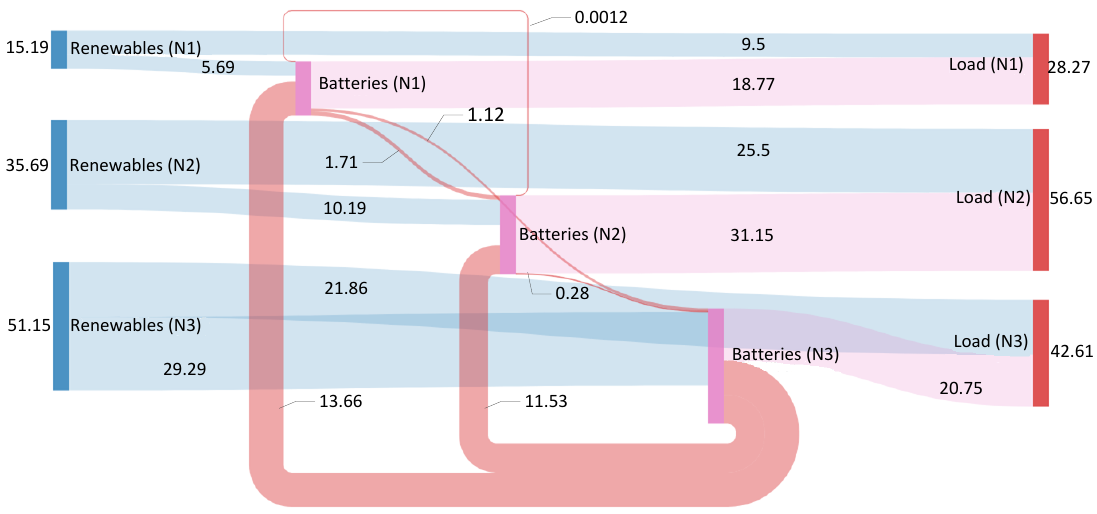
Figure 10. Total daily energy flow (kWh) in the microgrid with the NMPC enabled.